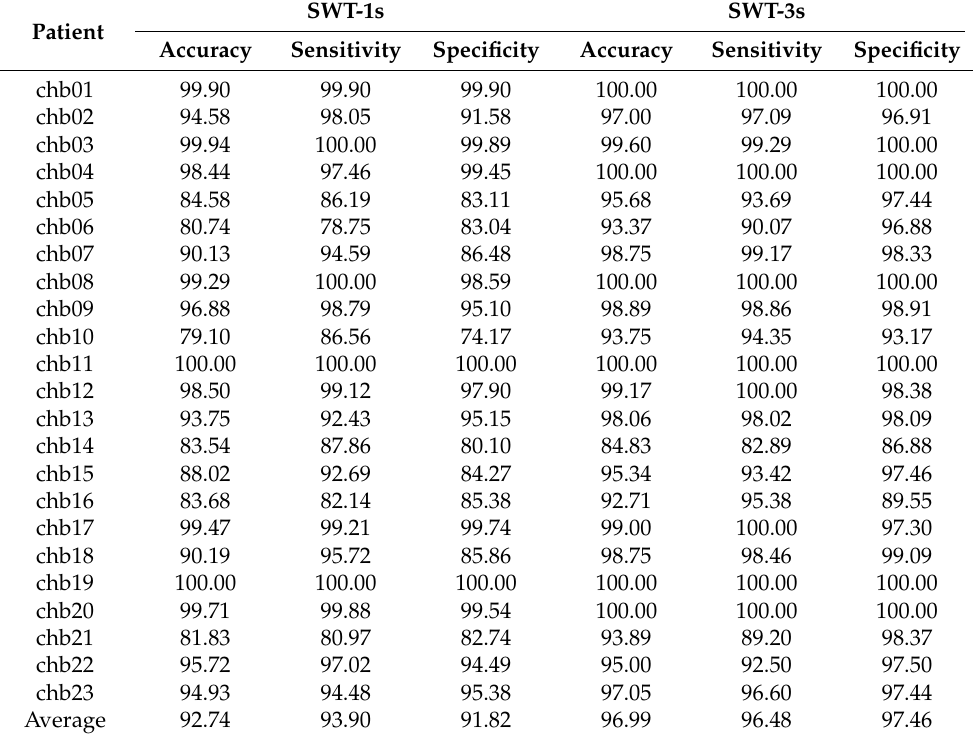
Table 5. The performance of 1 s and 3 s SWT segments under the proposed MLF-CNN model.